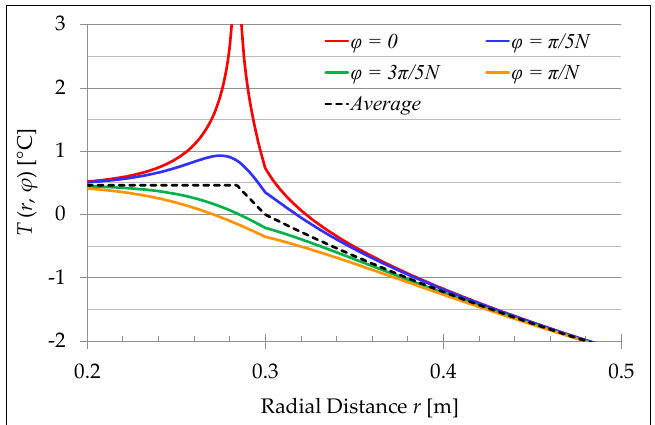
Figure 4. Radial temperature profiles for φ = 0, π /(5 N ), 3 π /(5 N ), and π / N . The dotted curve shows the average temperature T polav ( r ), (46).